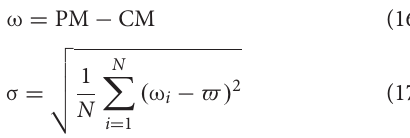
Frontiers in Earth Science |